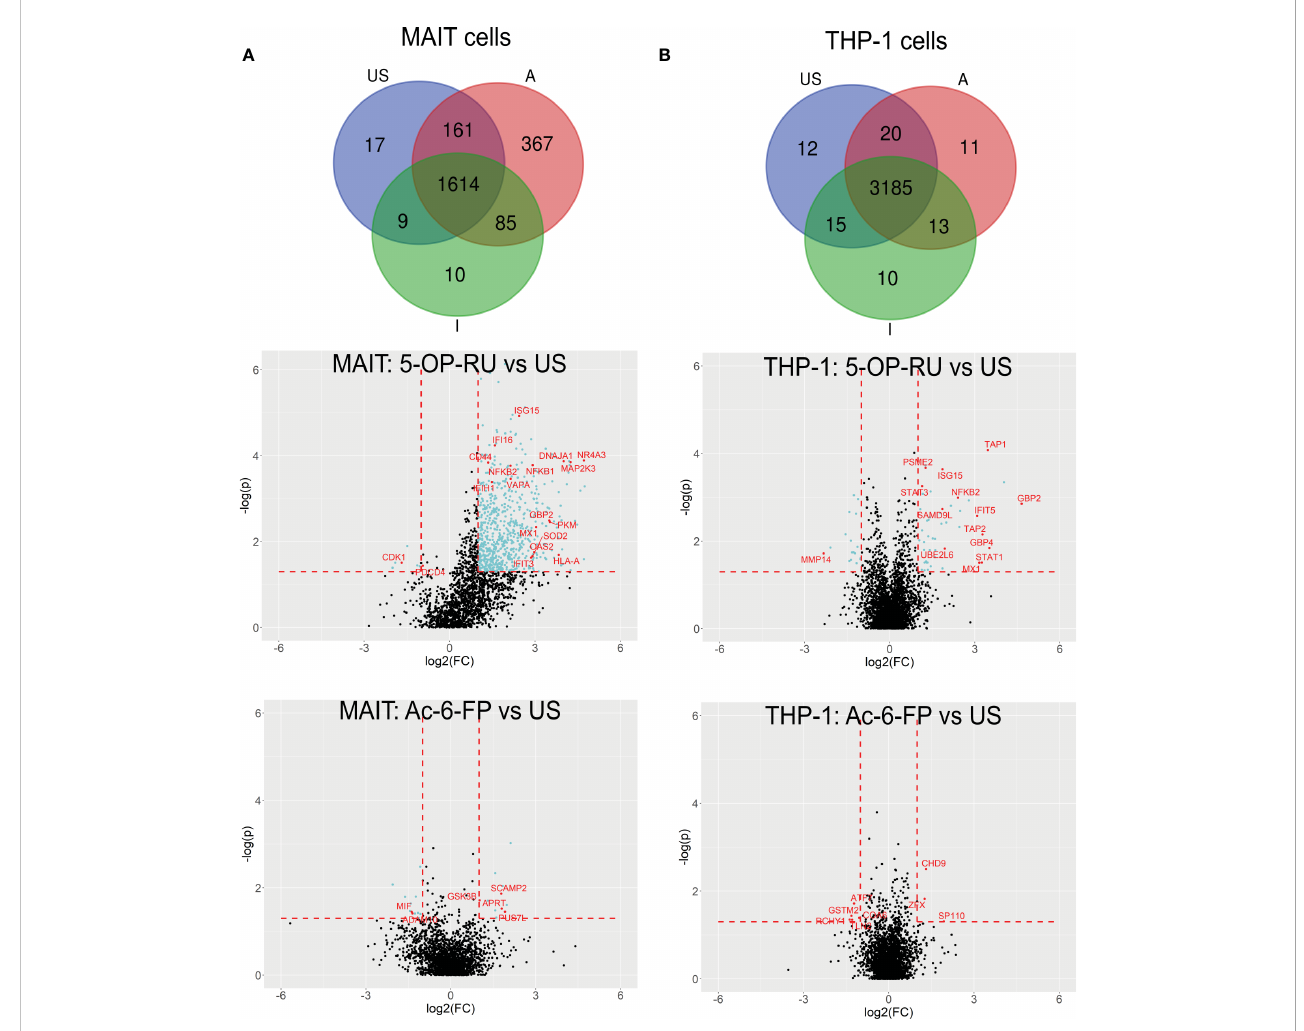
FIGURE 3 5-OP-RU-activated MAIT and THP-1 cells reveal a distinct pro-in fl ammatory translatome pro fi le. Top: Venn diagrams showing MAIT (A) and THP-1 (B) proteins that were identi fi ed in each condition in at least four of six donors from the bicellular system. Bottom: Volcano plots visualizing differentially abundant proteins of primary human MAIT cells (A) and THP-1 cells (B) from the bicellular system. Differentially abundant proteins (p<0.05; log 2 (FC)>[1]) are highlighted in light blue. Most abundant proteins or proteins supporting the pro-in fl ammatory translatome pro fi le are labeled with their gene names in red. Data from three independent experiments from six donors are shown. US=unstimulated; A=5-OP-RU; I=